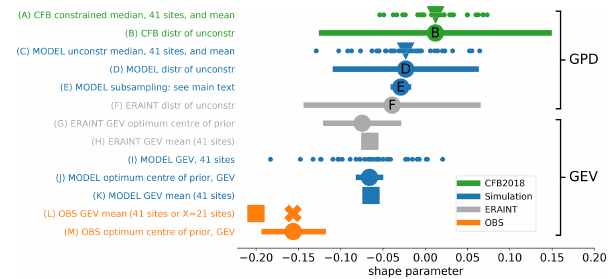
Figure D1. Further shape parameter results. (A–F) diagnosed by GPD fit to POT as Fig. 3. (G–M) diagnosed by GEV fit to annual maxima.